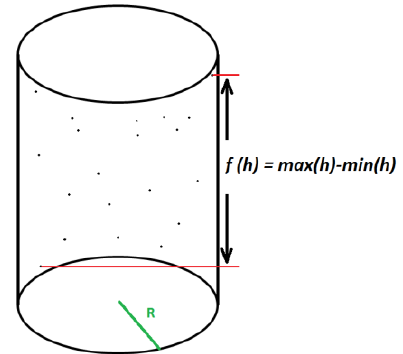
Figure 3. Schematic view of the criterion used in the HDB